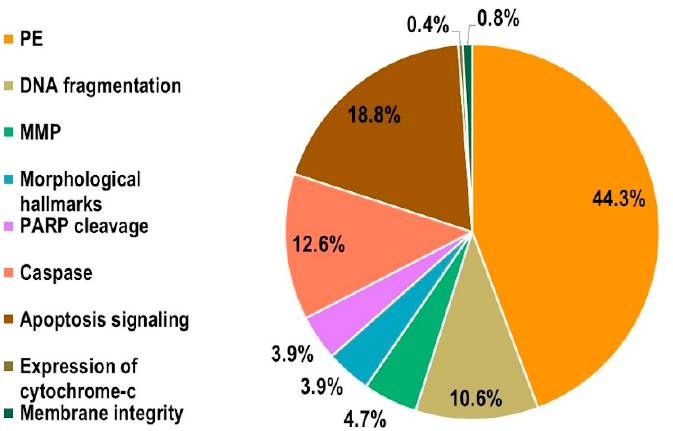
Figure 5. Percentage of endpoints analyzed in the experiments (MMP: mitochondrial membrane potential; PE: phosphatidylserine externalization; PARP: Poly(ADP-Ribose) Polymerase).